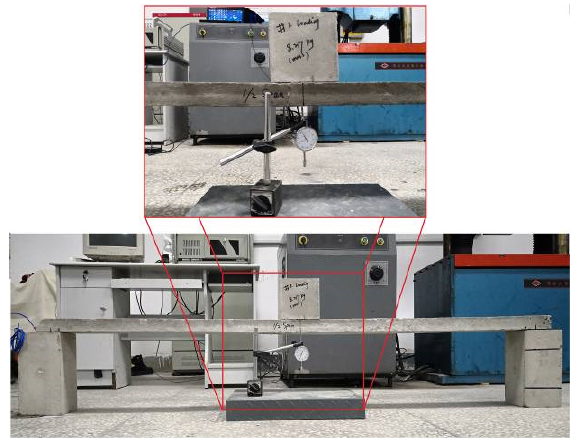
Figure 7. Setup for equivalent elastic modulus test.